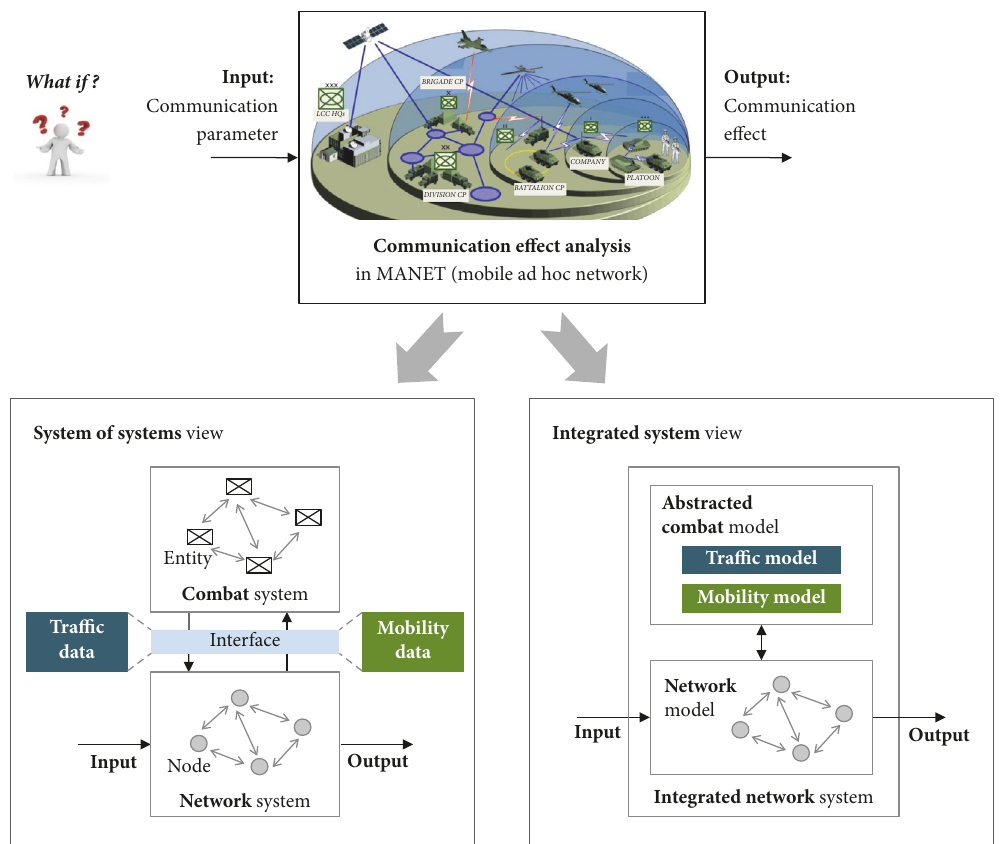
Figure 1: Communication analysis from two systematic perspectives: system of systems (SoS) and integrated system views.